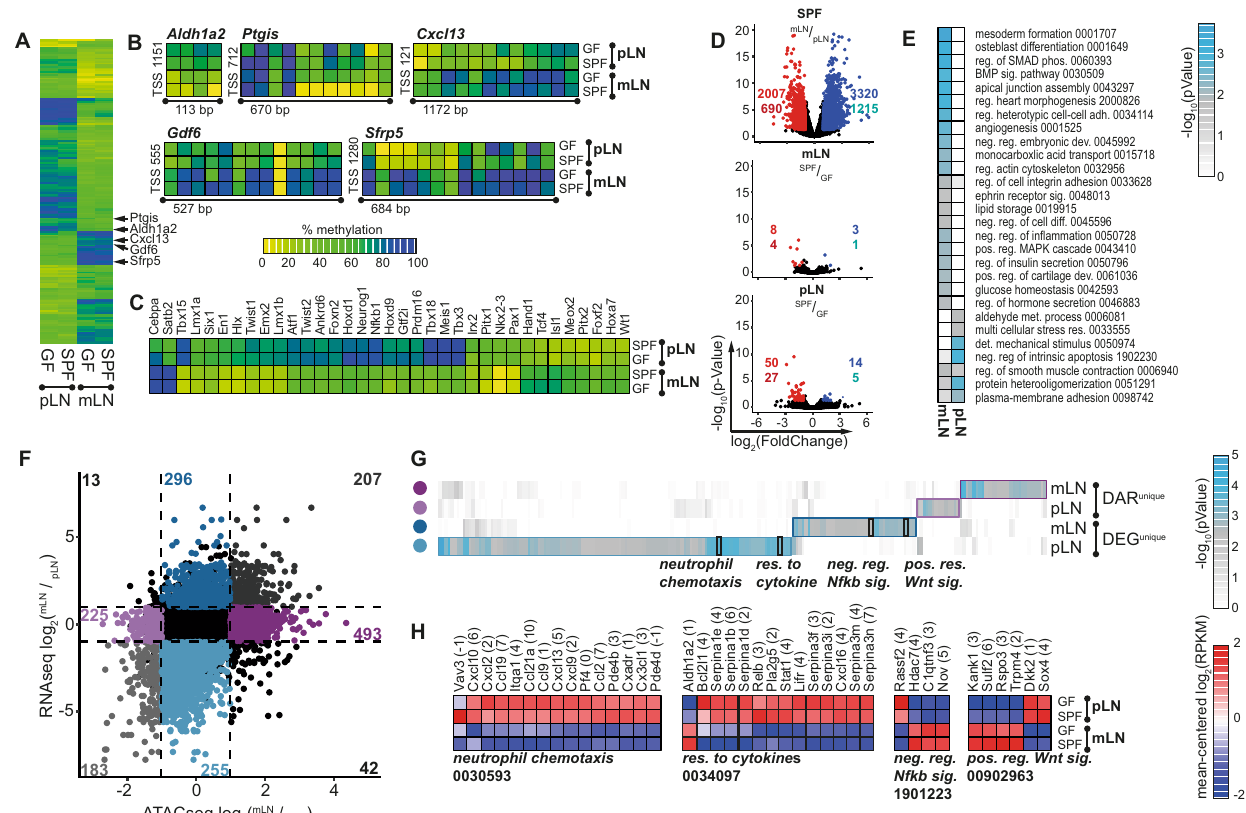
Fig. 4 | LN location de fi nes the epigenomic landscape of non-endothelial SCs. CD45 - CD24 - CD31 - Pdpn + non-endothelial SCs were isolated from mLNs and pLNs of 6 – 10weeksoldGFor 7 – 12weeksoldSPFmice, and WGBS( A – C ),ATAC-seq( D – G ), or RNA-seq ( F – H ) analyses were performed. A – C DMRs were identi fi ed in coloni- zation- (SPF vs. GF) and location-dependent (mLN vs. pLN) pairwise comparisons (2 – 3 replicates per condition). Scale bar depicts the extent of methylation with 100% being fully methylated and 0% being non-methylated. A The heatmap represents the mean methylation of signi fi cant DMRs within the promotor region of 286 genes. B Heatmaps represent CpG methylation of exemplary DMRs. The distance from the TSS is indicated and the size of genomic loci denoted in base- pairs (bp). C The heatmap represents the mean methylation of signi fi cant DMRs within the promotor region of TFs. D , E DARs were identi fi ed in colonization- (SPF vs. GF) and location-dependent (mLN vs. pLN) pairwise comparisons (3 replicates per condition). D Volcano plots of mean ATAC-seq FPKM comparing indicated samples. The number of DARs (top) and genes (bottom) is indicated per compar- ison. E GOanalysis of biological processes of genes with location-dependent